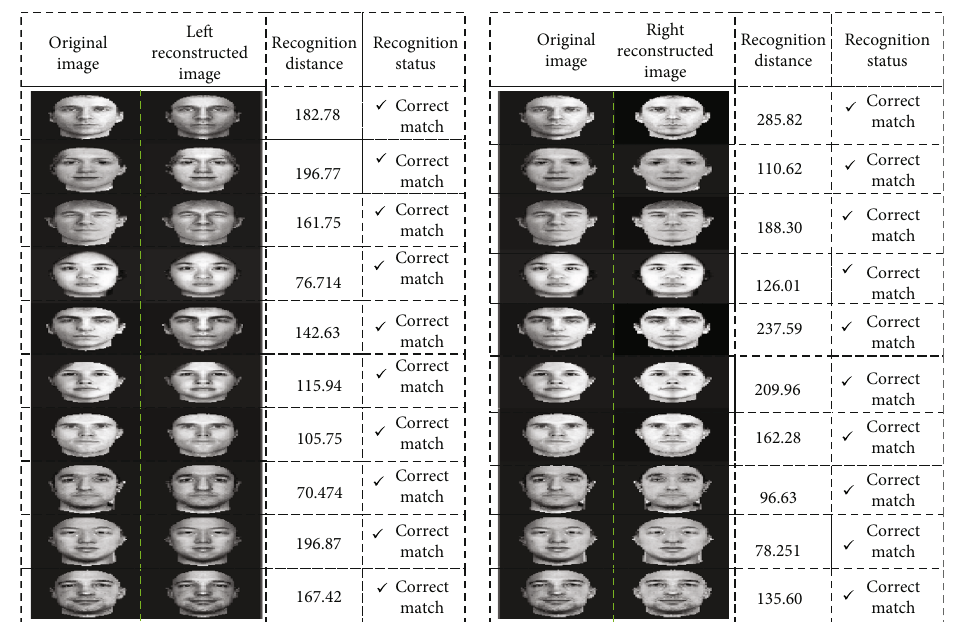
Figure 7: Recognition of the reconstructed images (MIT 2003-2005 database).